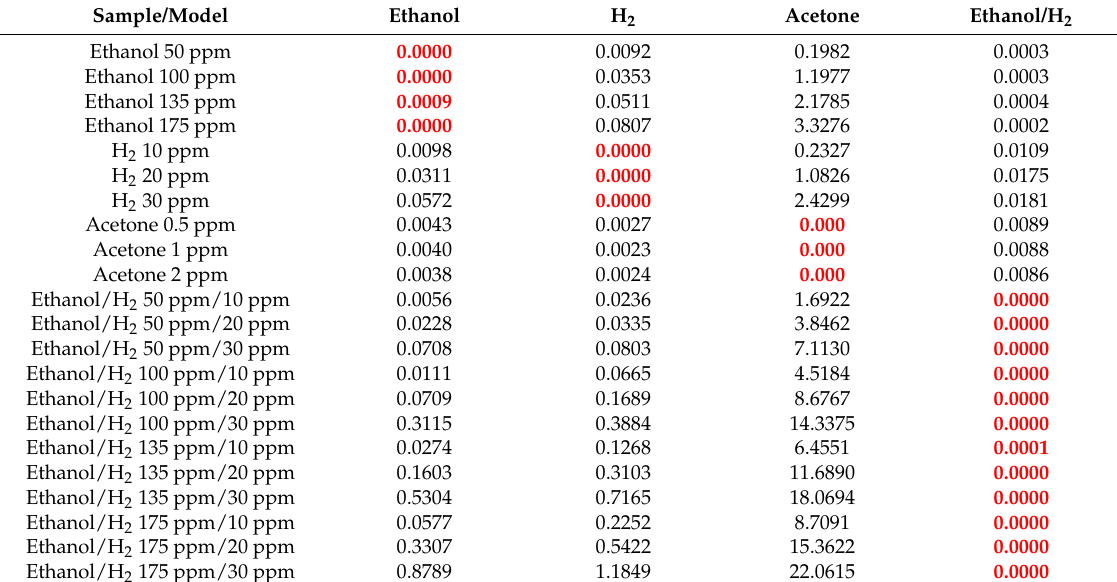
Table 3. Difference values between measured CTPs and theoretical CTPs.The decision value is set to 0.0001.